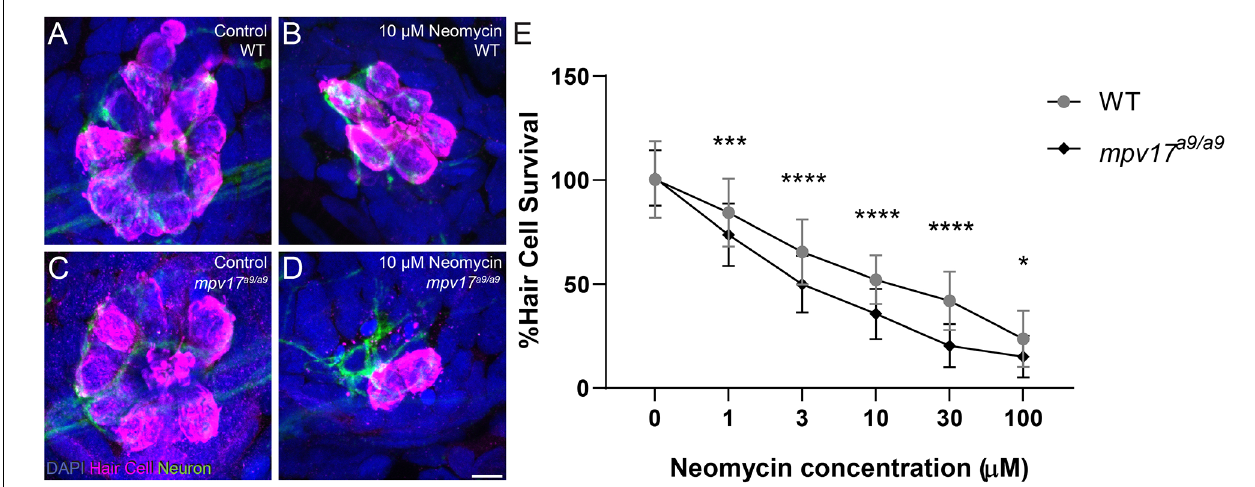
FIGURE 4 | mpv17 a9/a9 larvae are more sensitive to neomycin-induced hair-cell loss. (A–D) Maximum-intensity projections of confocal images of WT (A,B) and mpv17 a9/a9 (C,D) control neuromasts (A–C) or exposed to 10 µ M neomycin (B,D) . Hair cells were visualized with immunolabel of Parvalbumin (magenta), afferent neurites are expressing GFP (green), and all cell nuclei are labeled with DAPI (blue). (E) Dose-response curves showing hair cell survival as a percentage of control in both WT and mpv17 a9/a9 neuromasts (* P = 0.0115; *** P = 0.0001; **** P < 0.0001). n = 67–86 neuromasts (L3, L4, and L5); N = 3 experimental trials. Scale bar: 5 µ m. Error bars: SD.